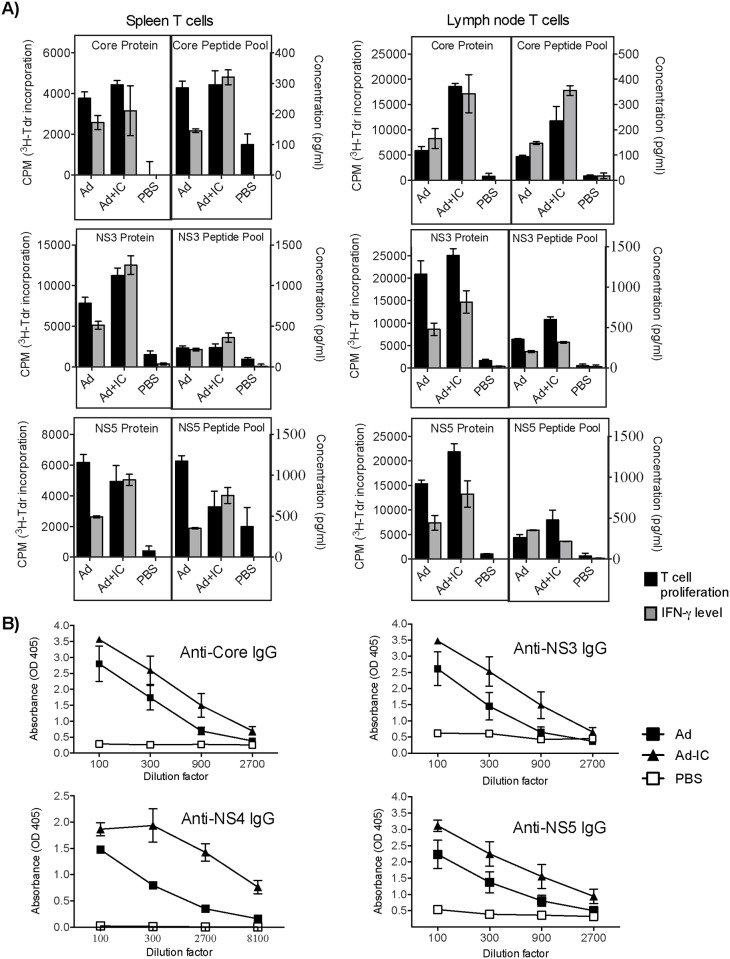
Identification of cross-reactive cellular and humoral immune responses in mice immunized with Ad vector (with or without poly I:C adjuvant).(A) Proliferation and IFN-γ production in spleen and lymph node T cells upon ex vivo stimulation with HCV antigens, or a pool of 5 peptides showing high homology with Ad proteins (see text for details). (B) Cross-reactive antibody response against HCV antigens. Data are presented as mean±standard deviation of 3–4 replicates, and represent more than three independent experiments.